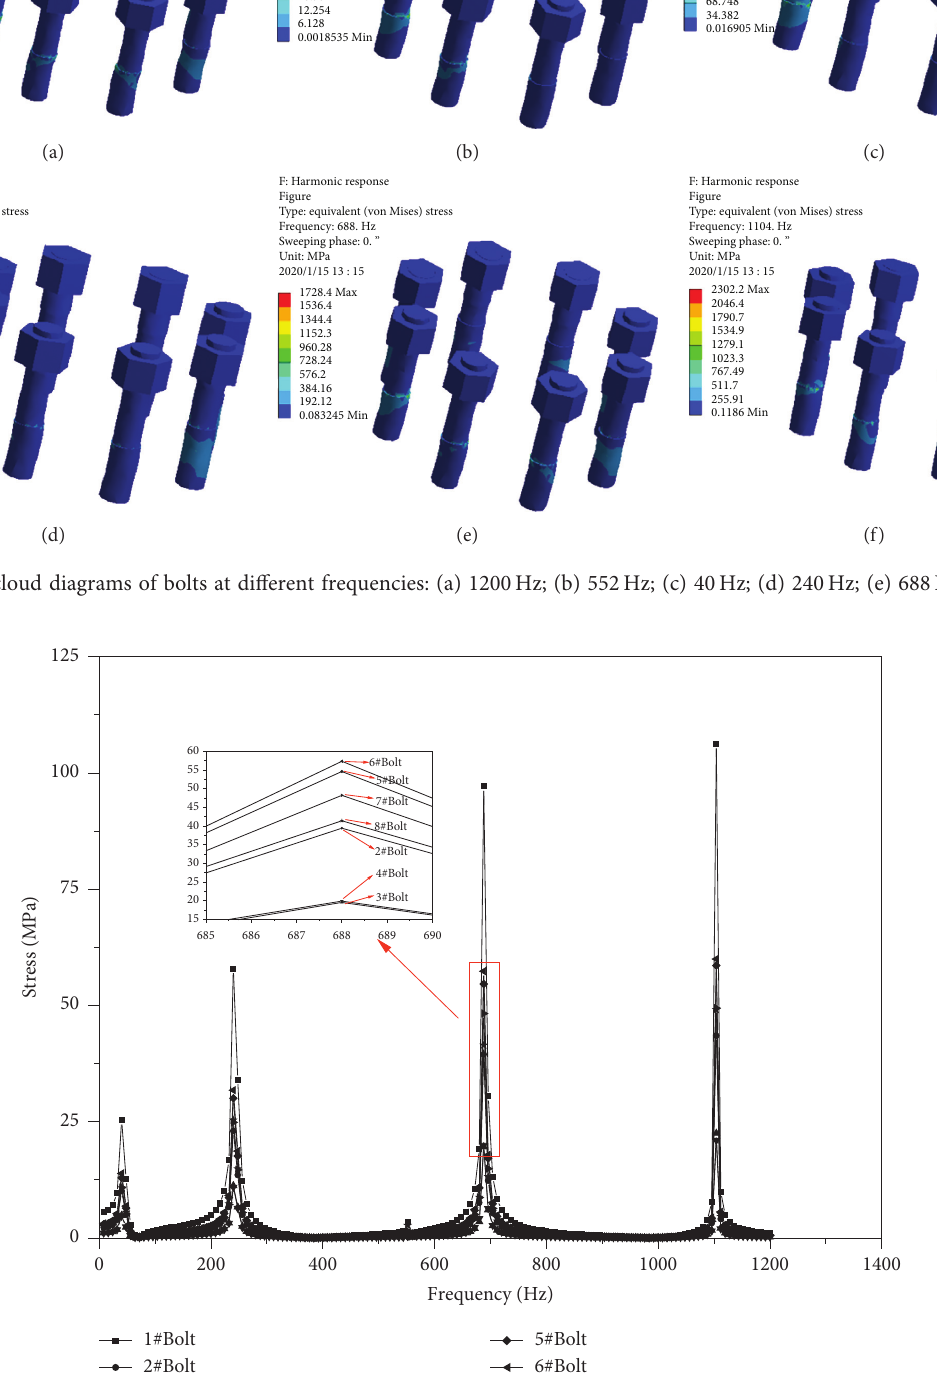
Harmonic response Figure Type: equivalent (von Mises) stress Frequency: 1200. Hz Sweeping phase: 0. ” Unit: MPa 2020/1/15 13 : 14